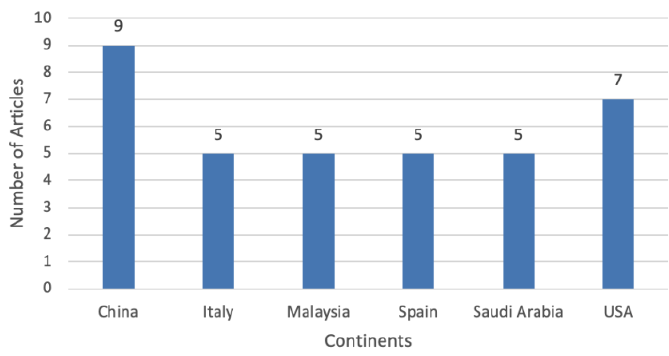
Figure 2: Geographical distribution of CGO articles